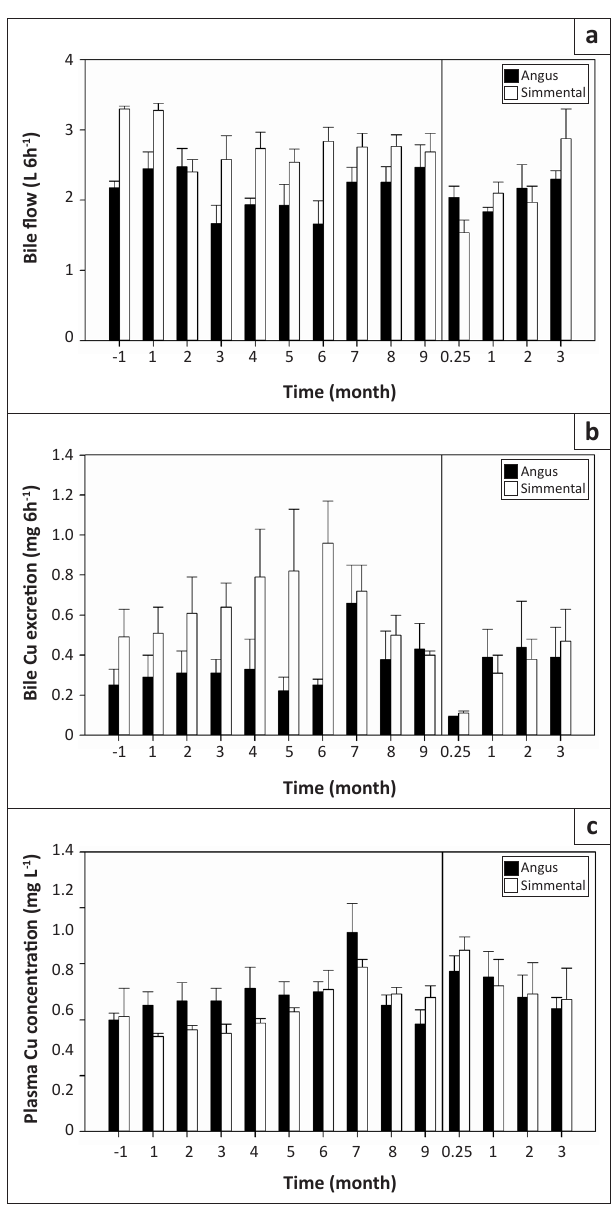
FIGURE 1: Bile flow, bile copper excretion and plasma copper concentration profiles in Simmental and Angus cattle prior to, during and following